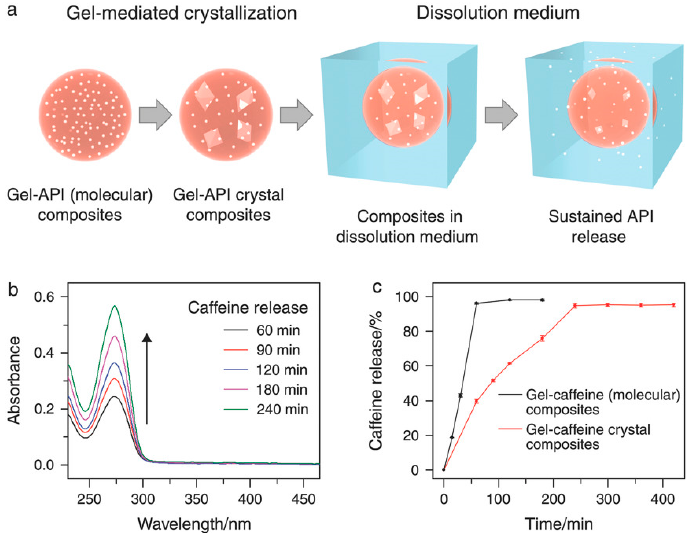
Figure 14. ( a ) Illustration of the process for sustained drug release from the TA–Ti(IV)–drug crystal Composites, ( b ) UV–vis absorption spectra of the caffeine released from the TA–Ti(IV)–caffeine crystal composite particles over time, ( c ) graph showing the release profiles of caffeine from the gel–caffeine composites. Reproduced with permission from Reference